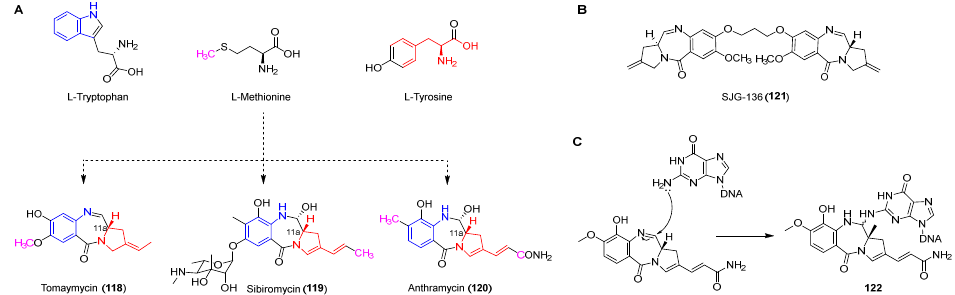
Figure 15. ( A ) Origins of pyrrolobenzodiazepines revealed by isotopic labeling experiments. ( B ) Chemical structure of SJG-136. ( C ) Proposed mechanism of DNA alkylating by pyrroloben-